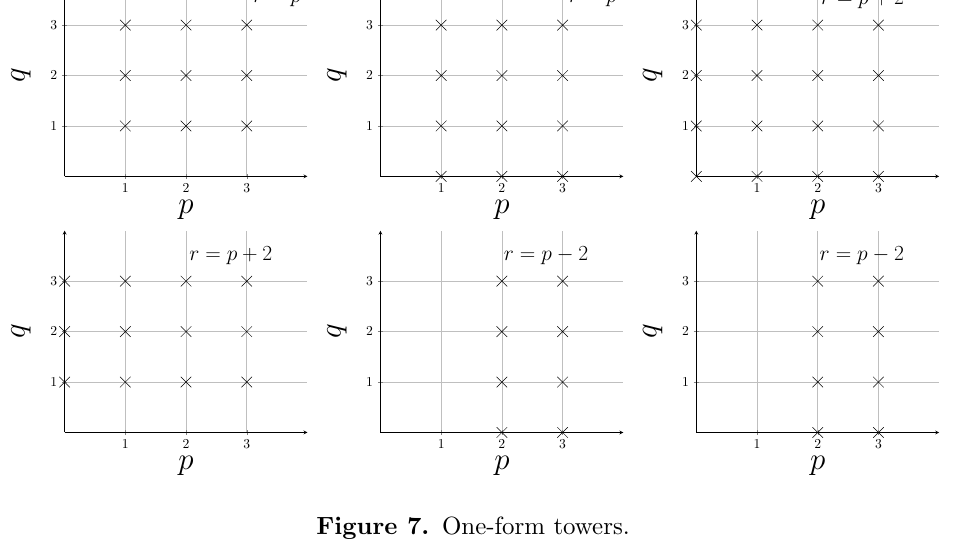
Figure 7. One-form towers.